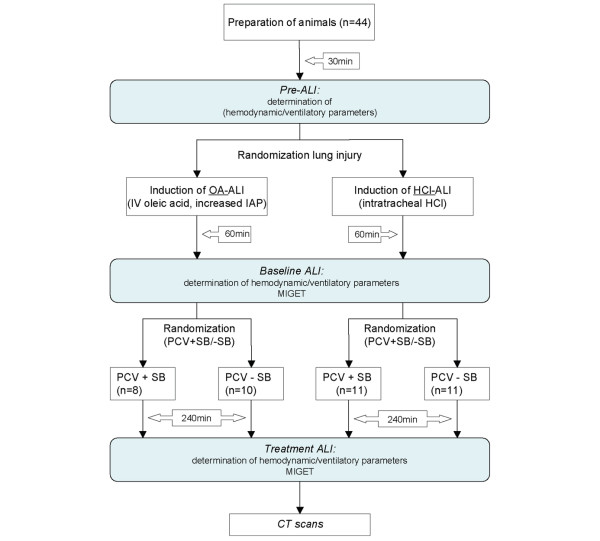
Flowchart of the study protocol. The grey boxes represent the measurement points. ALI, acute lung injury; CT, computed tomography; HCl, hydrochloric acid; HCl-ALI, hydrochloric acid-induced acute lung injury; IAP, intra-abdominal pressure; IV, intravenous; MIGET, multiple inert gas elimination technique; OA-ALI, oleic acid-induced acute lung injury (combined with an increased intra-abdominal pressure); PCV + SB, pressure-controlled ventilation with spontaneous breathing; PCV – SB, pressure-controlled ventilation without spontaneous breathing.